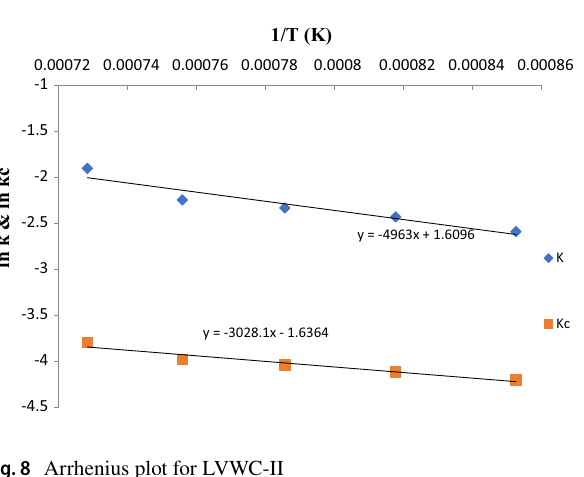
Fig. 8 Arrhenius plot for LVWC-II